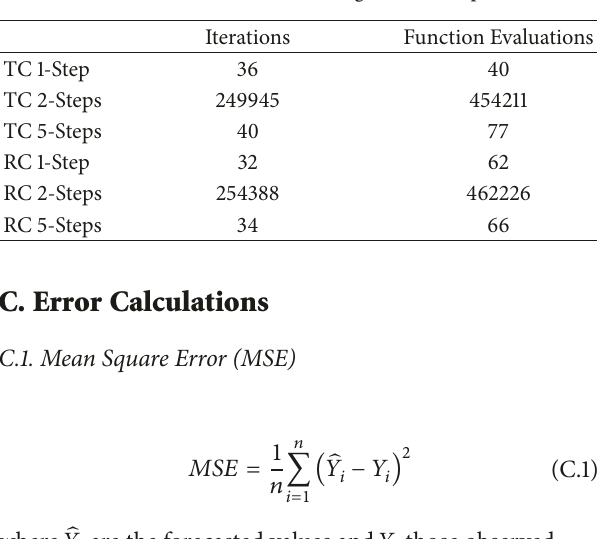
Table 18: Iterations on LES smoothing constants